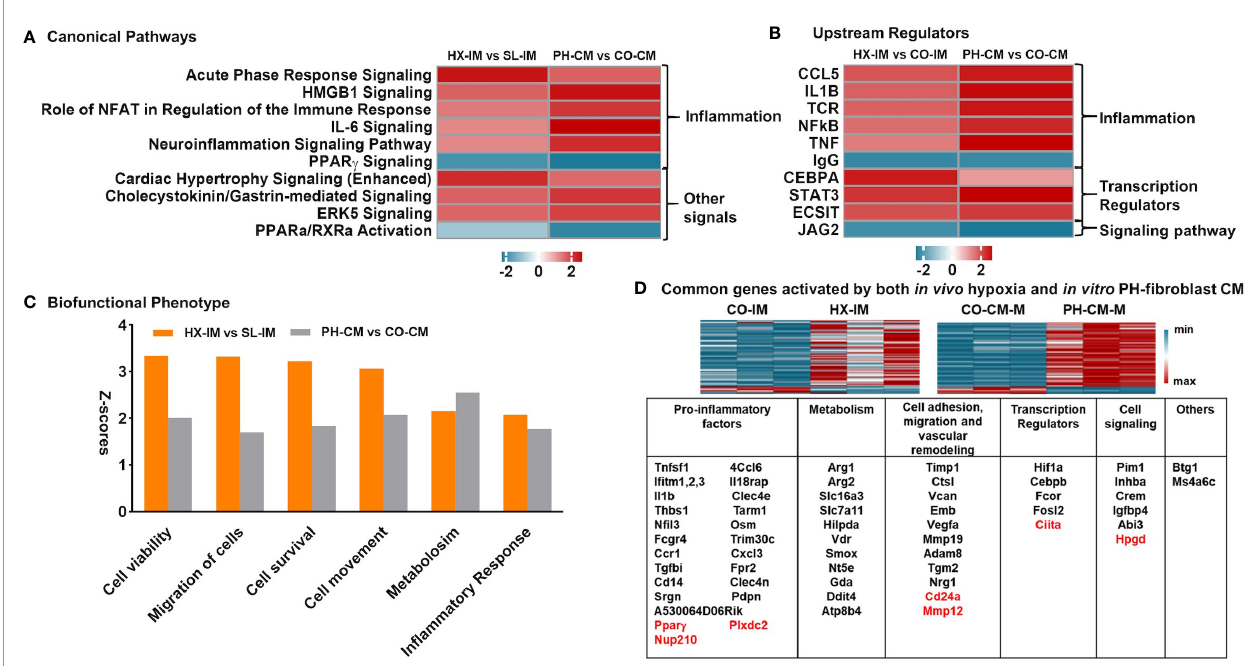
FIGURE 5 | In vivo lung interstitial/perivascular macrophages isolated from hypoxic mice and in vitro macrophages treated with PH- fi broblast conditioned media share pro-in fl ammatory and pro-remodeling gene pro fi les. RNA-seq data of in vitro PH-CM treated vs. CO-CM treated BMDMs and in vivo lung interstitial/ perivascular macrophages fl ow sorted from mouse exposed to 4-day hypoxia (HX-IM) vs. sea level (CO-IM) were analyzed. The cutoff criteria is q ≤ 0.05 and FC ≥ |2| in order to match the differing data set sizes and to limit our fi ndings to only the most biologically signi fi cant pathways. Ingenuity Pathway Analysis identi fi ed similarities in: (A) Canonical pathways, (B) Upstream regulators, and (C) Biofunctional phenotypes, part of Disease and Biofunctional pro fi le analysis, with z-score ≥ |2.0| in at least one dataset and p -values of overlap ≤ 0.05 in both data sets. (D) Common genes signi fi cantly regulated by both in vivo hypoxia and in vitro PH-CM. Genes were clustered in fi ve key categories by their functions: pro-in fl ammation, metabolism, cell adhesion/migration/vascular remodeling, transcription regulators, and cell signaling. Down-regulated genes are highlighted in